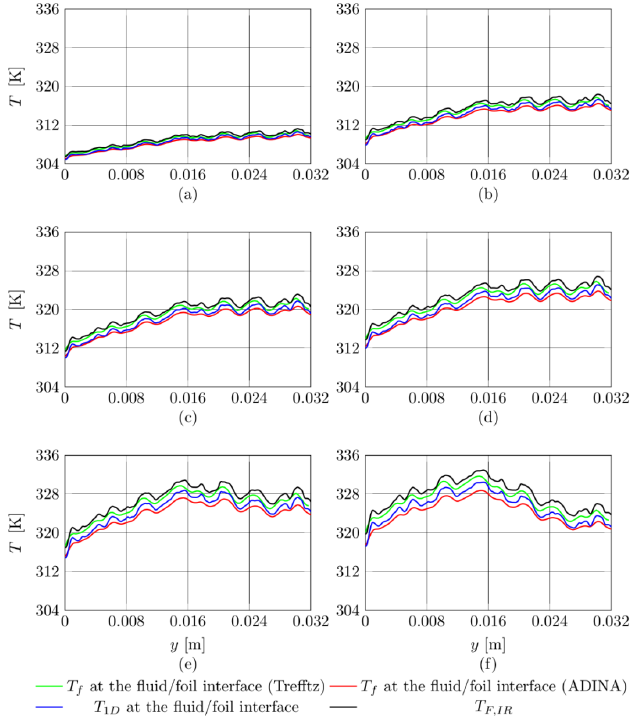
Figure 9. Temperature vs. the distance from the minichannel inlet at the fluid/foil interface obtained from 2D computations using the Trefftz functions (green line), ADINA software (red line), according to the 1D approach (blue line) and T F,IR ( y )—the data from experimental measurements on the outer foil surface due to infrared thermography (black line); the test section with five minichannels; experimental parameters listed in Table 2, heat flux values: ( a ) q” = 13.8 kW / m 2 ; ( b ) q” = 24.6 kW / m 2 ; ( c ) q” = 31.3 kW / m 2 ; ( d ) q” = 38.7 kW / m 2 ; ( e ) q” = 47.2 kW / m 2 ; ( f ) q” = 55.8 kW / m 2